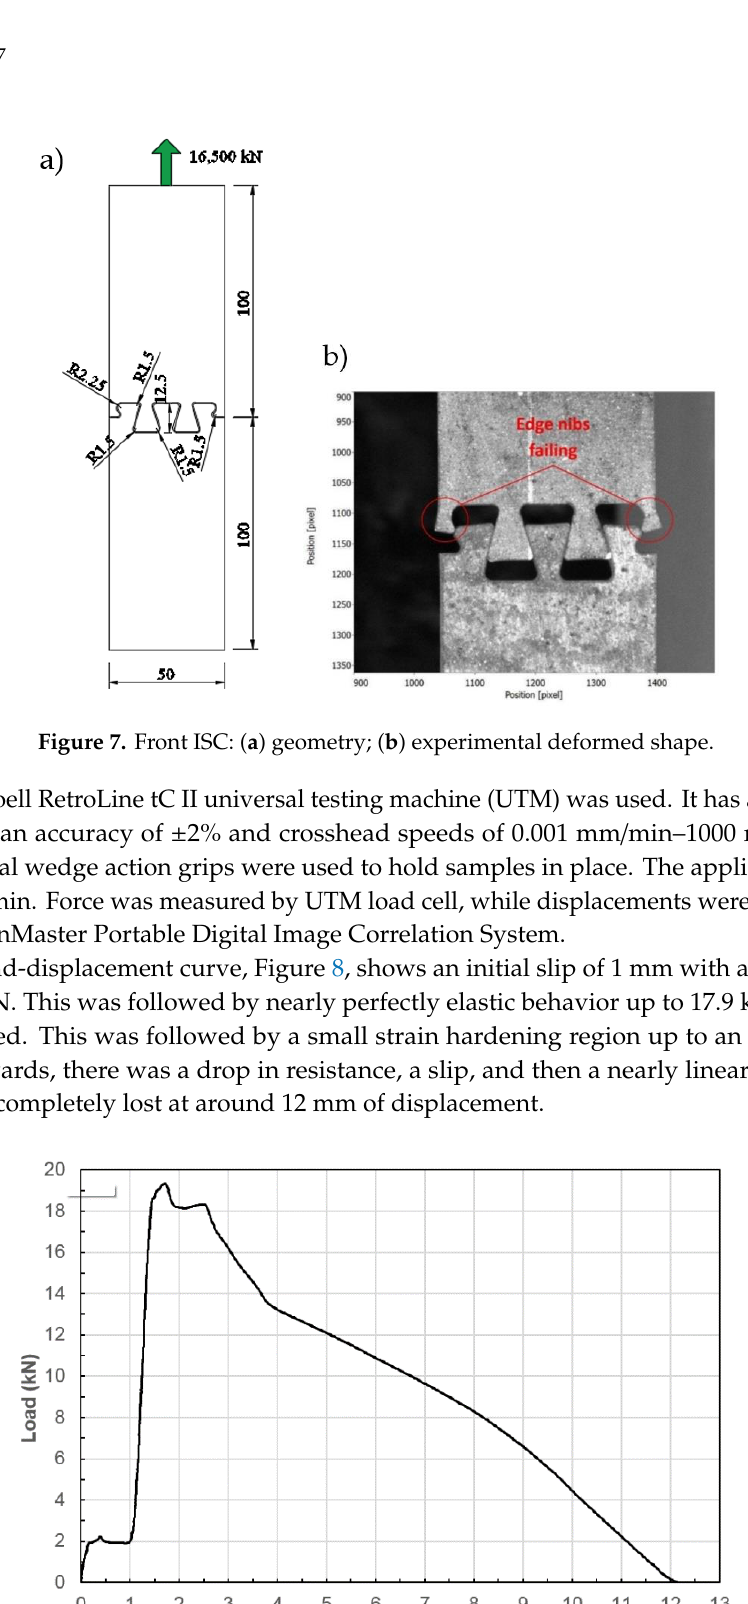
Figure 8. Experimental load-displacement curve.